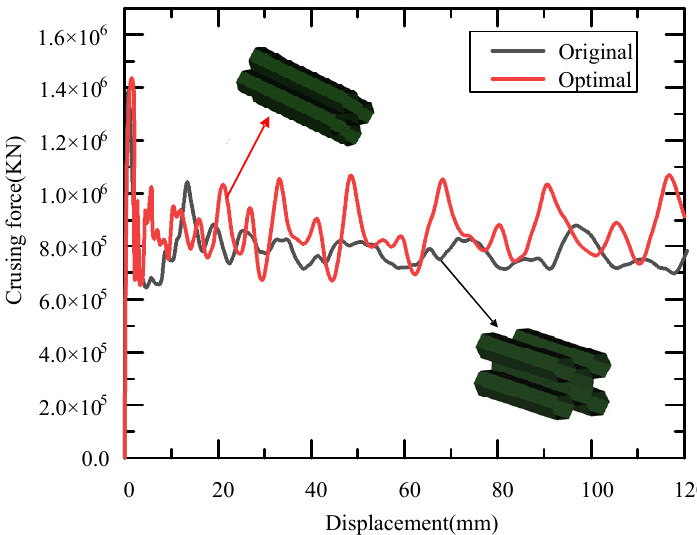
Machines. 2022 , 12 , x FOR PEER REVIEW Figure 13. Pareto front solution: ( a ) Pareto front; ( b ) the optimal parameters results.